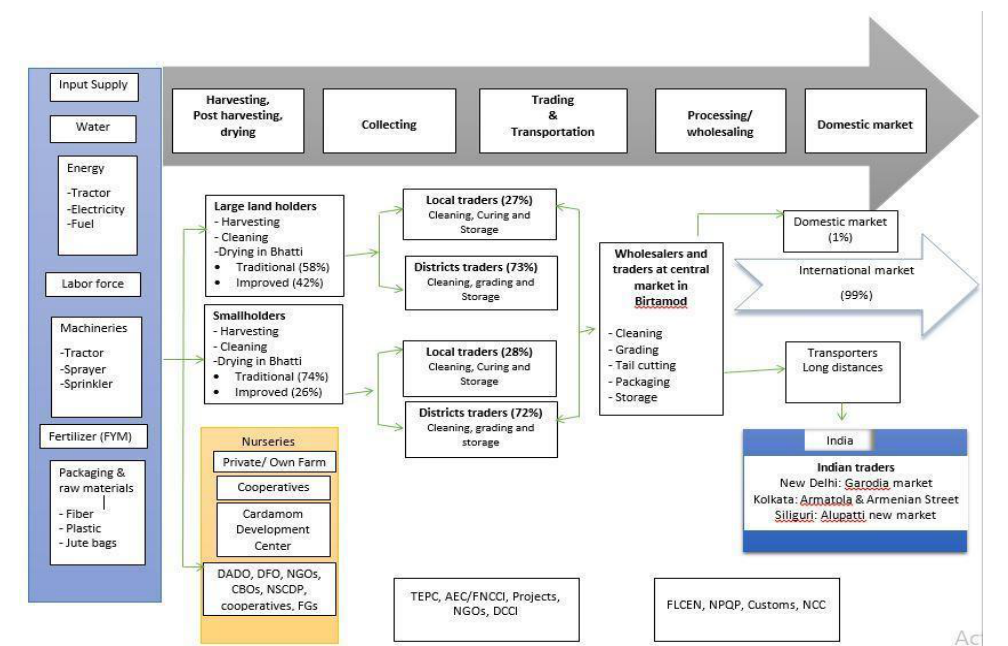
Figure 4 Value chain map of large cardamom in the study